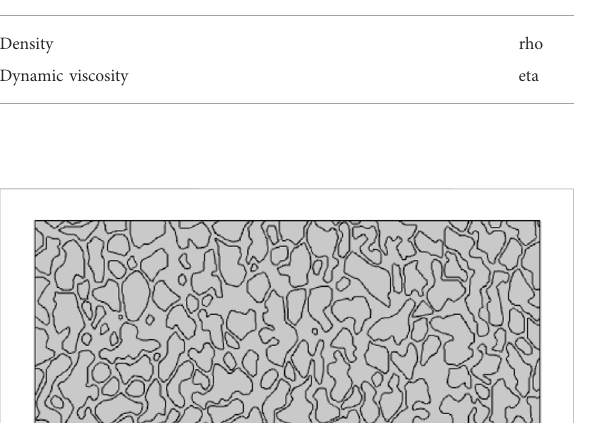
TABLE 2 Parameter names.